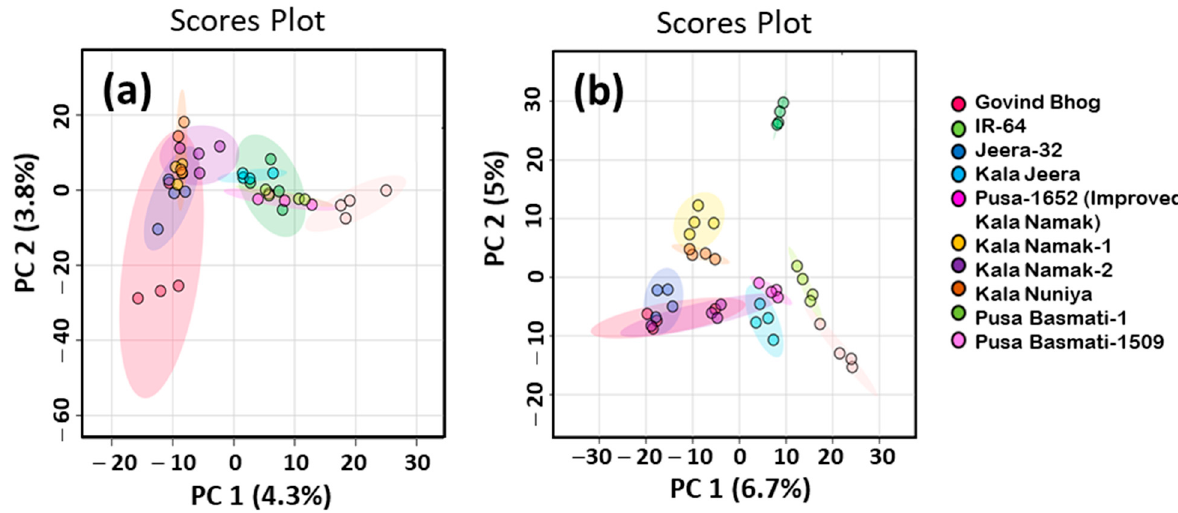
Figure 2. Principal component analysis (PCA) score plots of volatile compounds in ( a ) raw and ( b ) cooked rice samples of ten different traditional and improved varieties.